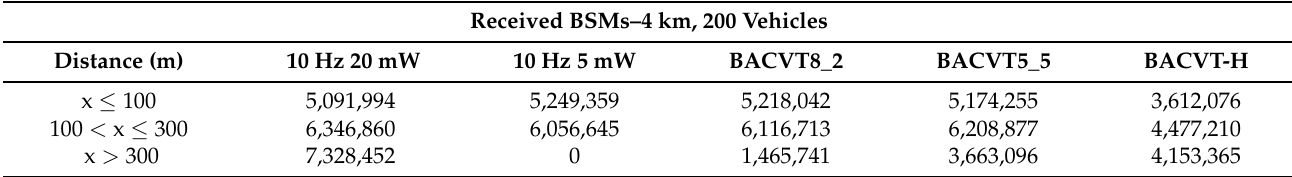
Table 4. Received BSMs in high vehicle density.